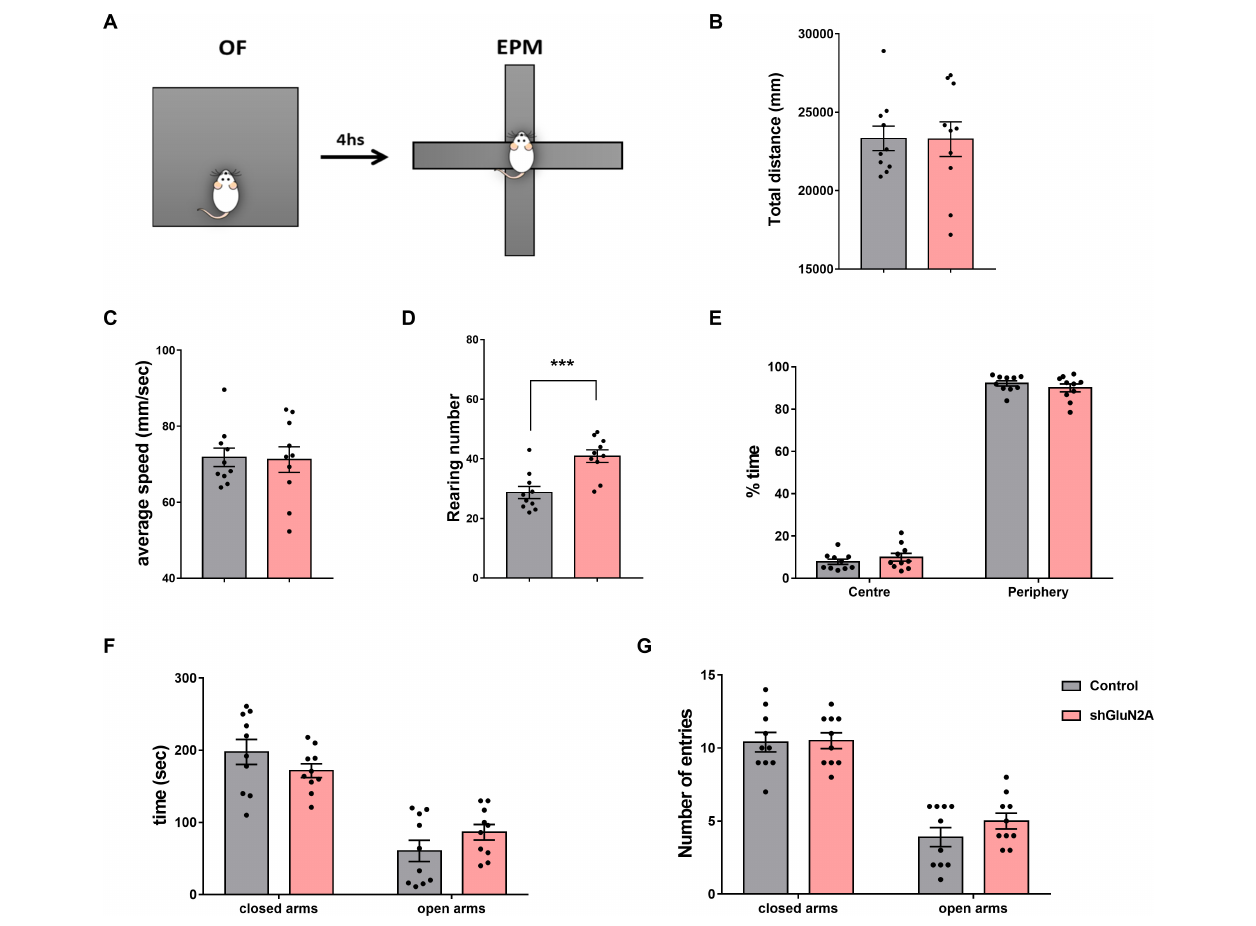
FIGURE 6 | Anxiety-like behavior analysis. (A) Experimental design: shGLUN2A- and shsc-injected rats were exposed to an open field (OF) for 5 min, and 4 h later to the elevated plus maze (EPM) task for 5 min (B–E) OF analysis. No significant differences were observed in total traveled distance ( B , Horizontal exploration, p = 0.9690, unpaired t test) or in locomotor activity ( C , average speed, p = 0.8872, unpaired t test) between control and KD animals. (D) shGluN2A-injected animals showed a significant increase in vertical exploration (rearing behavior), compared to controls (*** p < 0.001, unpaired t test). (E) There was no difference in region preference (center/periphery) during arena exploration between the two groups ( p = 0.5711, unpaired t test). (F,G) EPM analysis. Both groups explored the open and closed arms similarly, measured as time spent in the open or closed arms ( F , p = 0.3161, unpaired t test) and number of entries into the arms ( G , p = 0.9089 and p = 0.3783, unpaired t test). Data are represented as mean ± SEM. Animals: N = 10 shsc-injected, N = 10 shGLUN2A-injected.